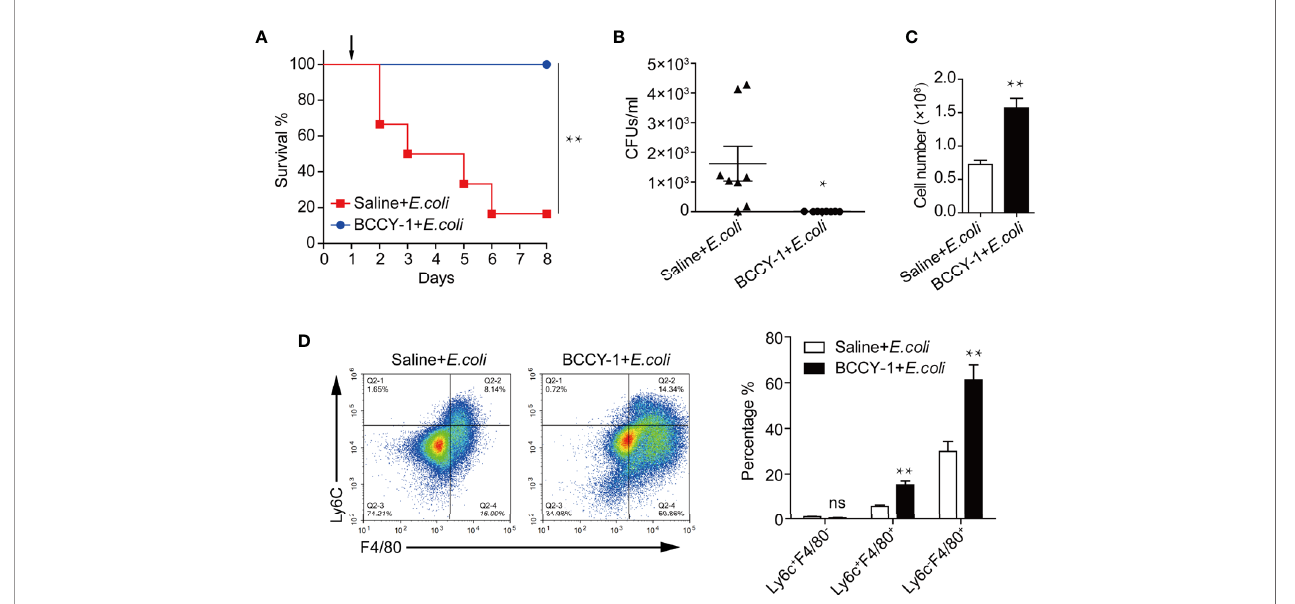
FIGURE 4 | Ef fi cacy of BCCY-1 in bacterial infection models. (A) C57BL6/J mice were infected by i.p. injection with 1×10 8 CFUs/mouse of E.coli . BCCY-1 (10 mg/ kg/day) or saline was administered by i.p. injection 48 h before E.coli challenge. Survival of mice was recorded. The day of challenge was designated as day 1 (black arrow). n=6. (B) Mice were treated i.p. with BCCY-1 (10 mg/kg/day) 48 h hours before E.coli challenge. The bacterial load in the peritoneal lavage fl uid after 24 h of infection was shown by CFU counts. n=8. * p <0.05. (C) Cell number of nucleated cells in peritoneal lavage fl uid of each group. n=8. ** p <0.01. (D) Monocyte recruitment into the peritoneum after infection in each group was analyzed by fl ow cytometry. Quanti fi cation of monocyte/macrophage percentage is shown as a bar graph in the right panel. n=5. ns p >0.05, ** p